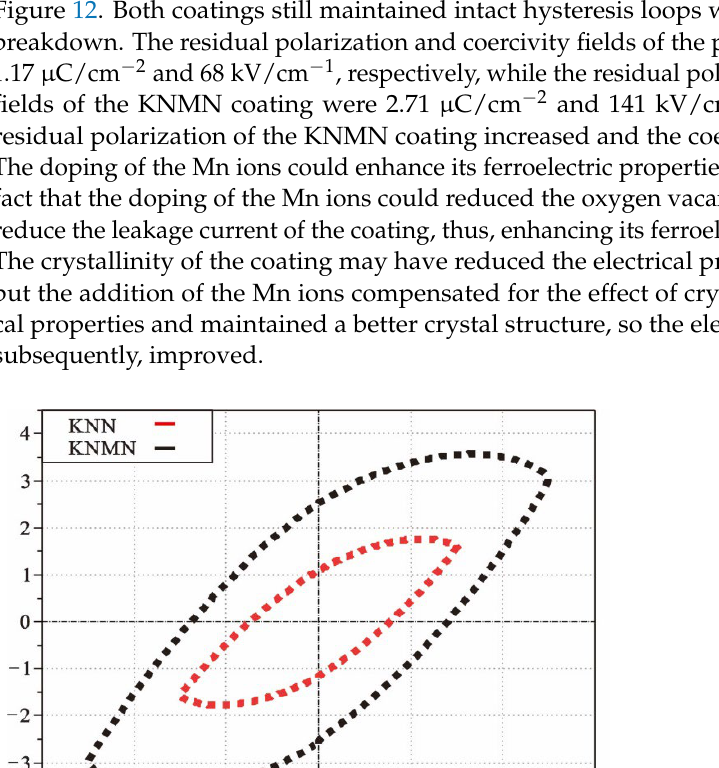
Figure 11. Dielectric spectrum of KNN and KNMN coatings.